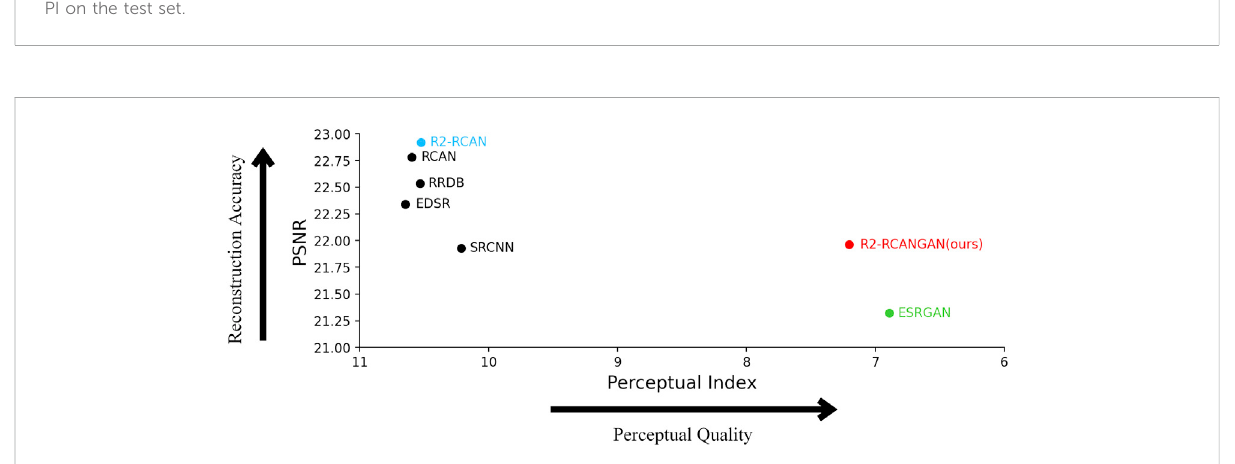
FIGURE 6 PSNR-PI plane on the test set. The PSNR-oriented methods such as R2-RCAN (blue) have very high reconstruction accuracy but very poor perceptualquality.ESRGAN(green)hasthebestperceptualquality,butthereconstructionaccuracyistoolow.OnlyR2-RCANGAN(red)doesnotfall into either extreme in the scatter plot, balancing reconstruction accuracy and perceptual